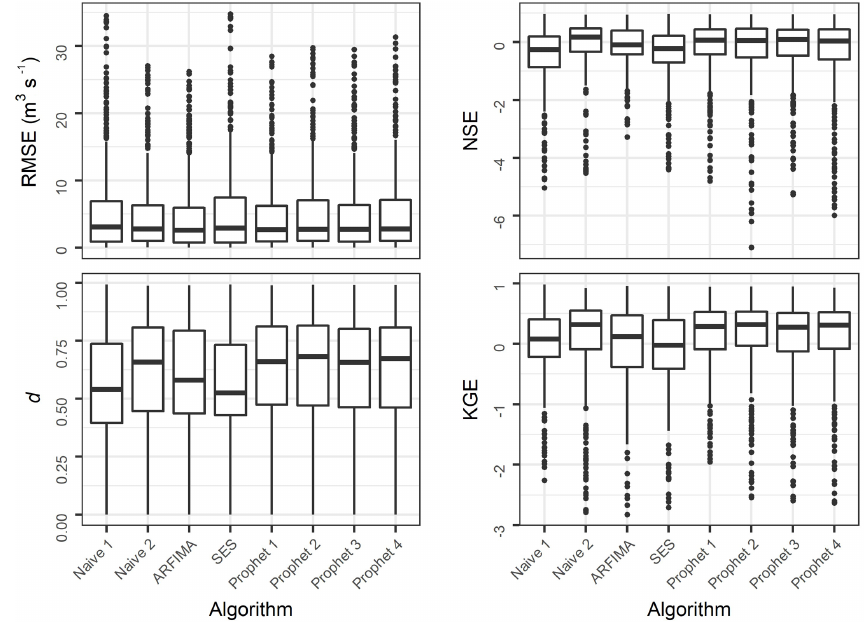
Figure 2. Metric values for the 513 catchments presented in an aggregated form. The far outliers (if any) have been removed.